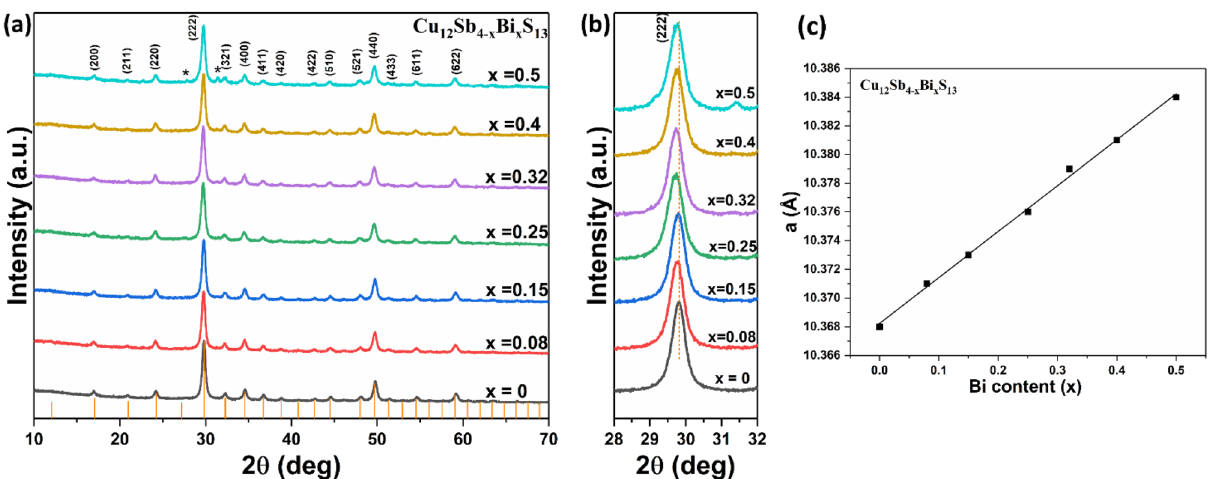
Figure 11. ( a ) p-XRD patterns of Cu 12 Sb 4−x Bi x S 13 (x = 0.08, 0.15, 0.25, 0.32, 0.4 and 0.5) and ( b ) the maximum intensity peak (222) of Bi-doped tetrahedrite samples. Orange lines are from standard ICDD: 01-088-0283 for